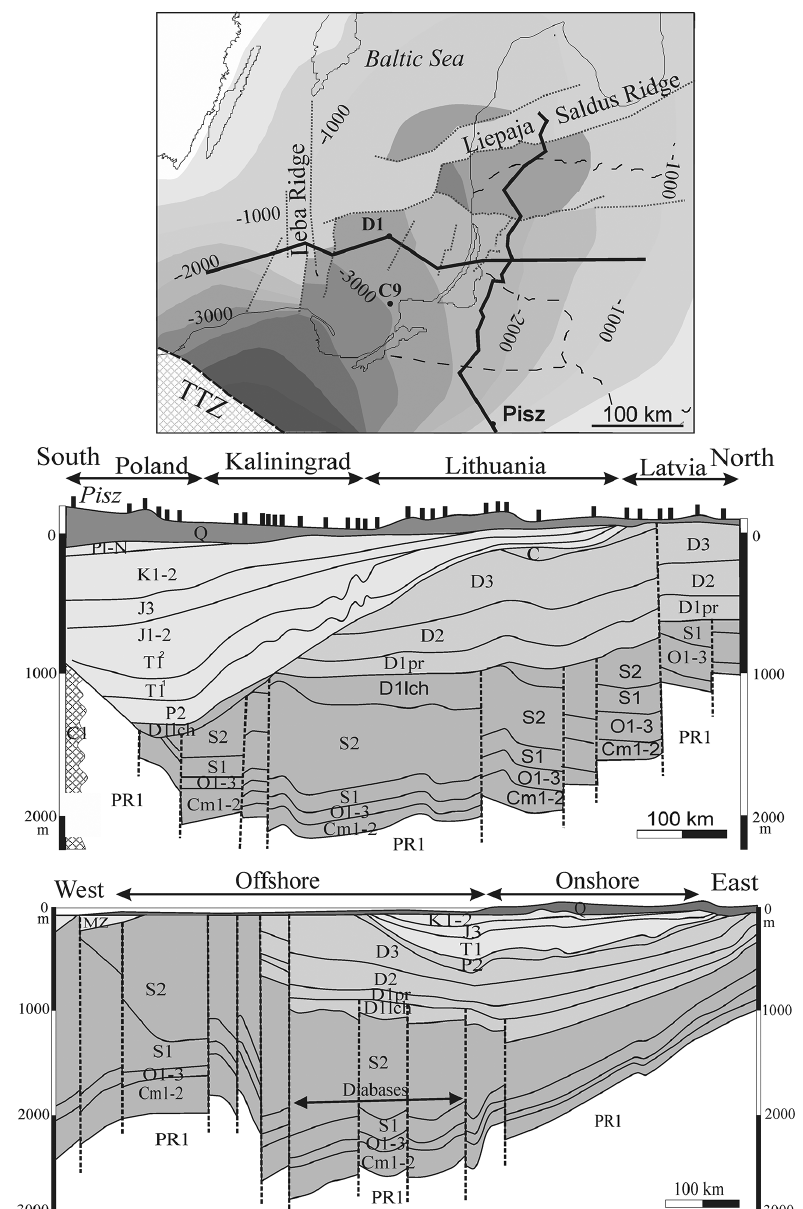
Fig. 12. S–N and W–E geological profiles. The upper figure shows locations of profiles and depths of the crystalline basement. Structural complexes are shown in different grey-scale